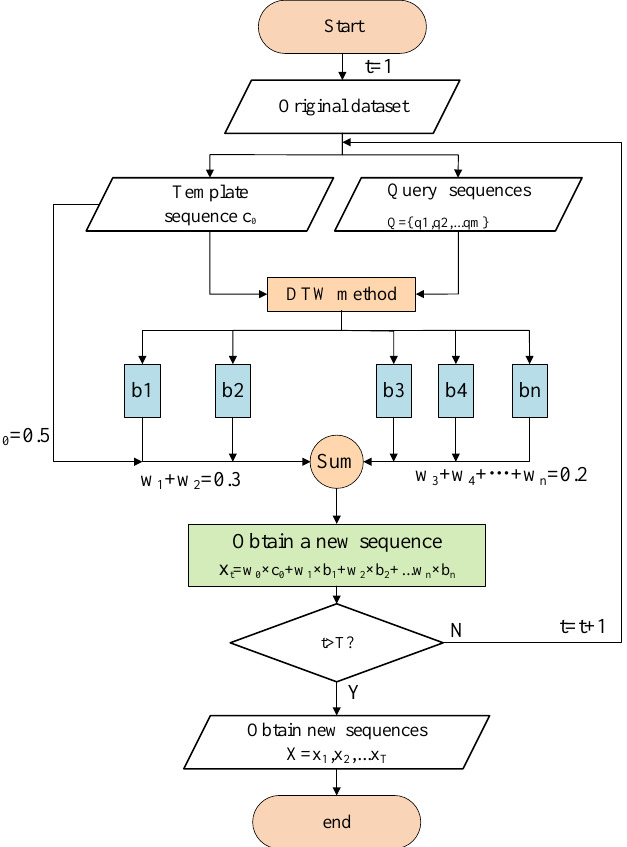
Figure 3. Data enhancement process based on the DTW algorithm.